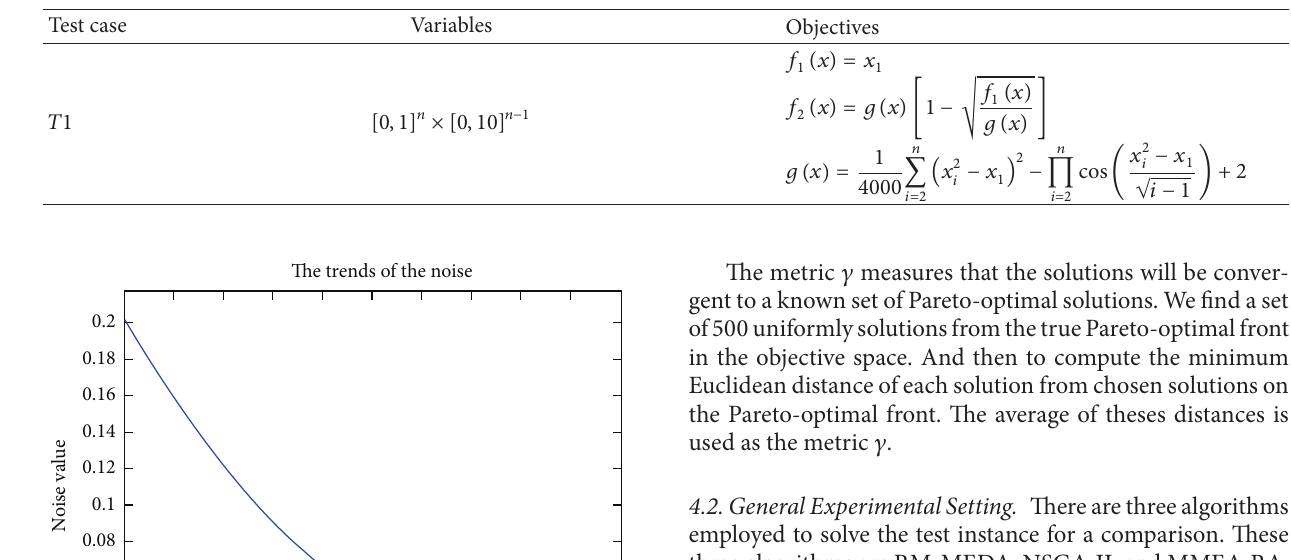
Table 1: Test instance.